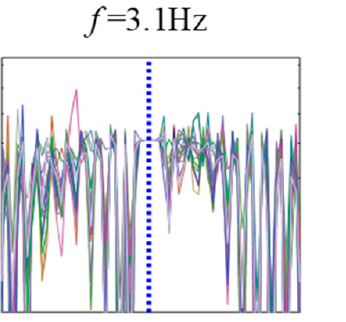
Figure 9. Local delayed TRF. ( a ) Excitation frequency 1; ( b ) excitation frequency 2.